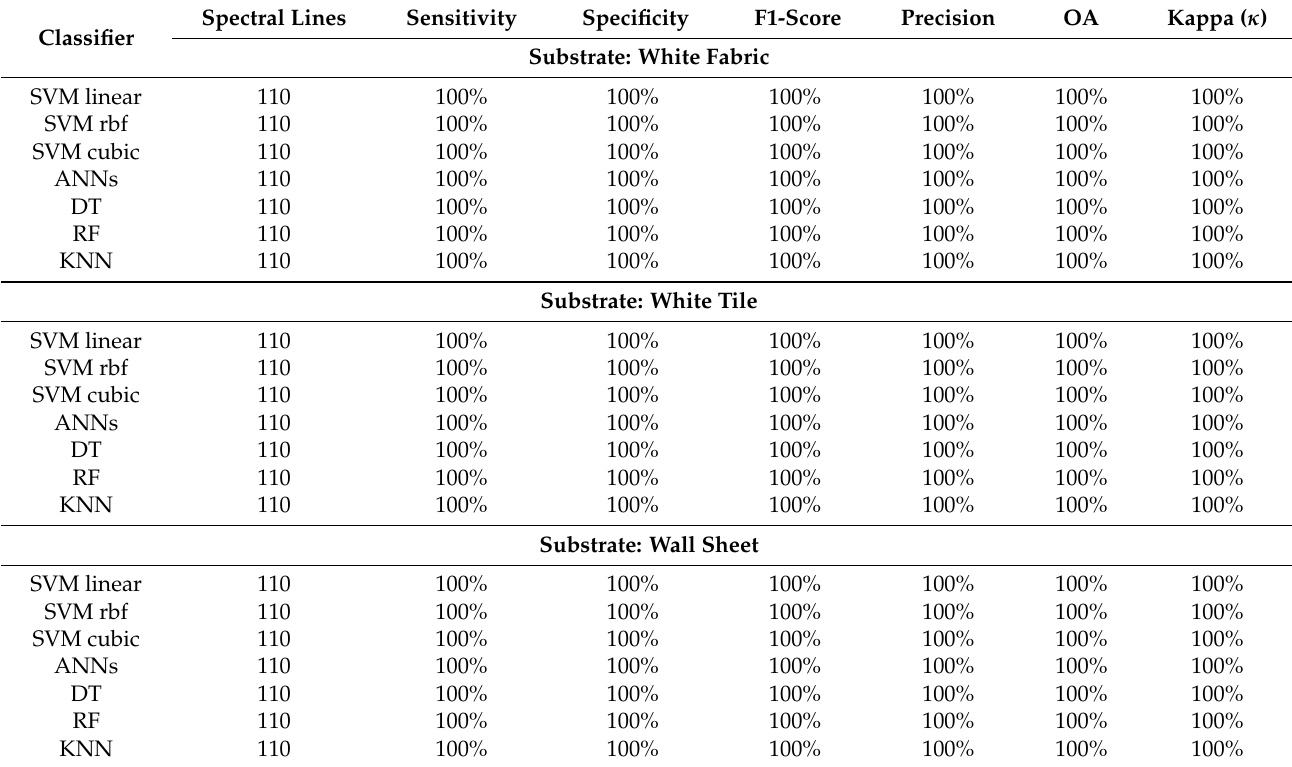
Table 4. Blood (donor 1) vs. non-blood experimental results over sample-based data splitting. Similar results have observed for other donors.